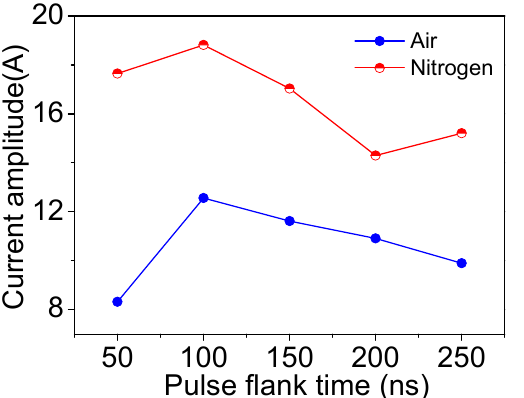
Figure 5. Effects of pulse rising and falling time on the peak values of the first and second discharge currents under air and nitrogen.